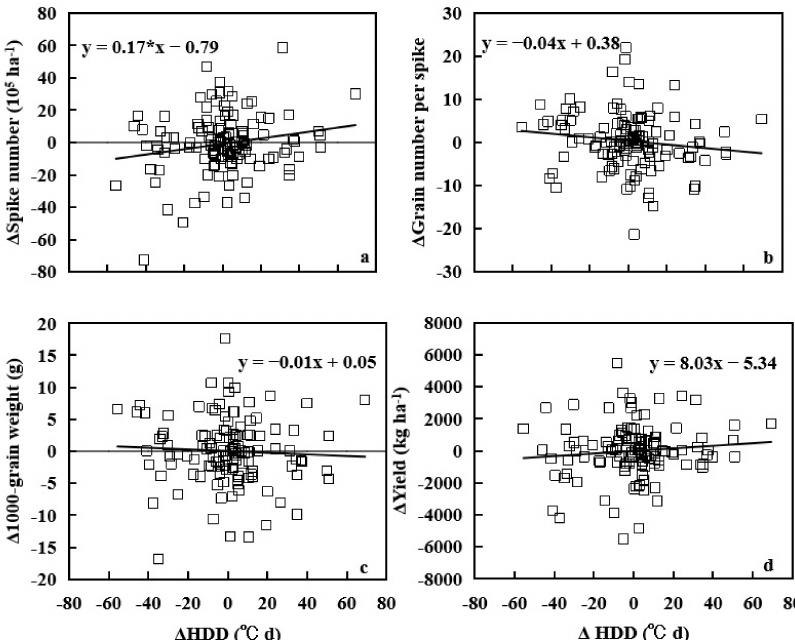
Figure 5. Relationships between year-to-year changes for heat degree-days ( ∆ HDD) and year-to-year changes for spike number ( ∆ Spike number, a ), grain number per spike ( ∆ Grain number per spike, b ), 1000-grain weight ( ∆ 1000-grain weight, c ) and wheat grain yields ( ∆ Yield, d ). Heat degree-days was calculated from daily values from anthesis to maturity. Yield and yield components data were obtained from China agro-meteorological experiment stations in which fertilization and irrigation were optimized to achieve the local highest possible yields. * Significant at p <